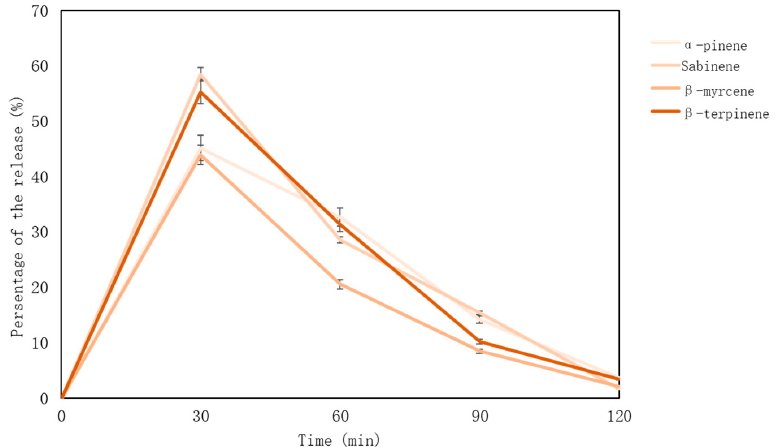
Figure 4. Monoterpenes’ release from nutmeg essential oil-loaded lyophilized microcapsules (%).